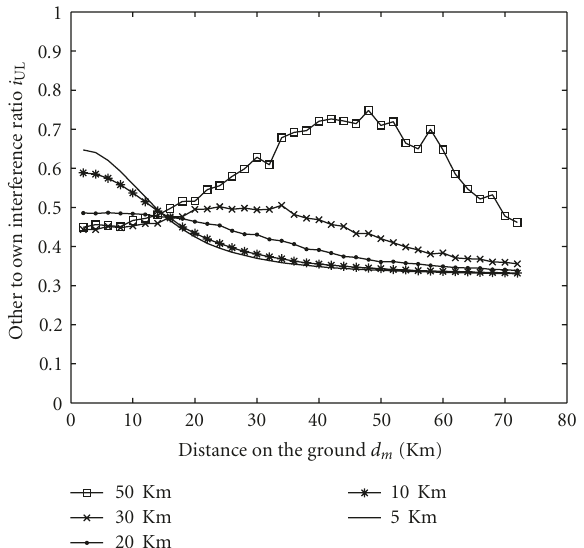
Figure 7: Illustrating the e ff ect of HAP base station cell radius on interference levels. A system of 3 HAPs is utilized here and a voice service (12kbps) from one HAP in combination with the data service (384kbps) on the other HAPs. The distance on the ground d m is varied from 0 to 70